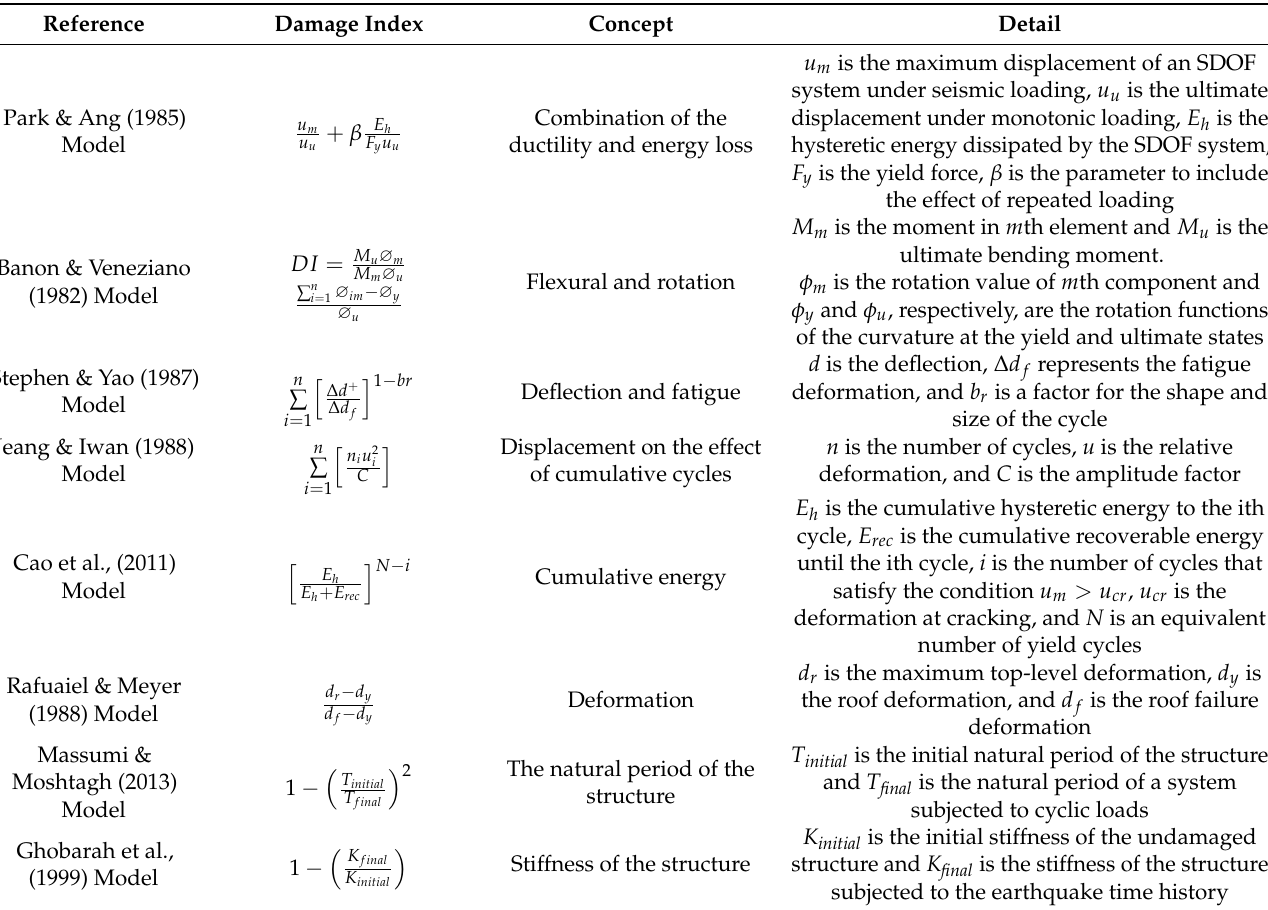
Table 1. Summary of the Damage Indices and the